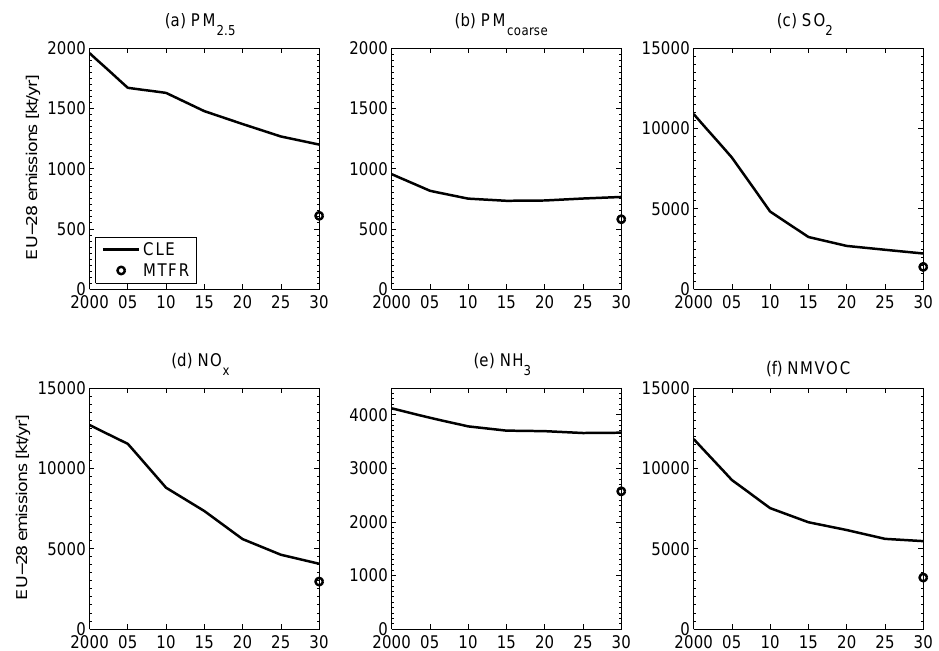
Figure 9. Bottom up calculated emissions of PM and its precursor gases in the EU-28 under current legislation (lines) and the maximum technically feasible reductions in 2030 (circles).